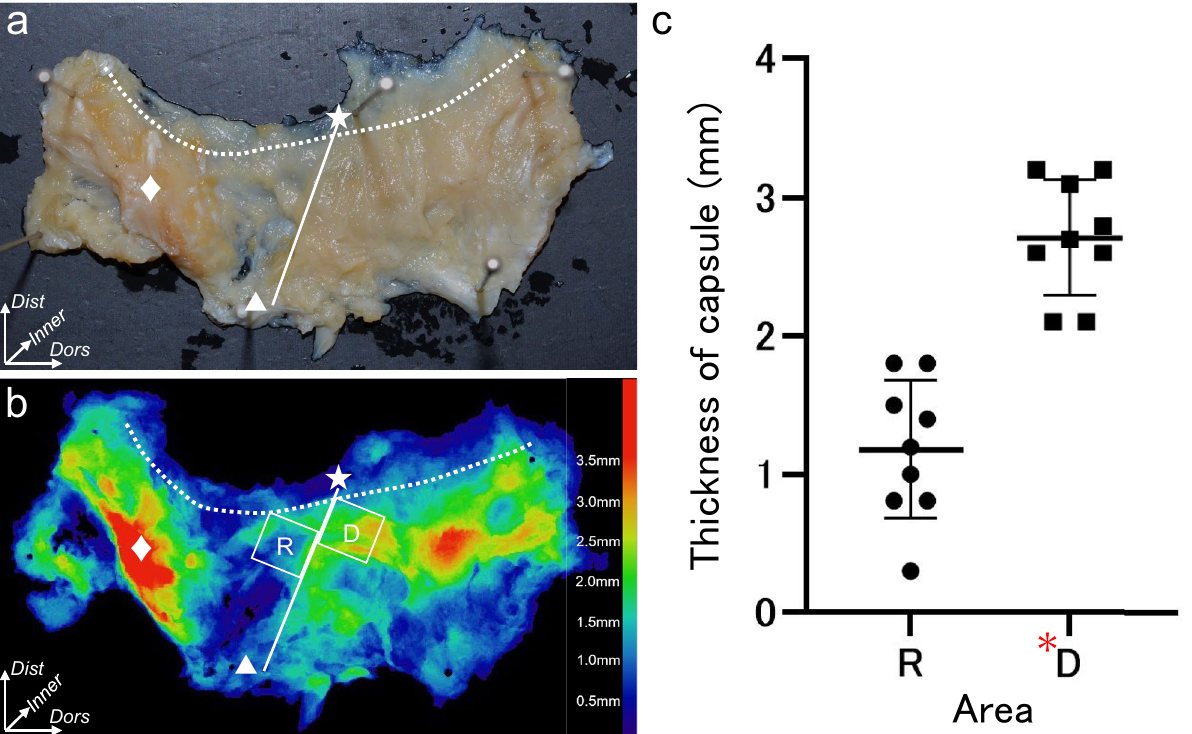
Figure 5. Distribution of the local thickness of the trapeziometacarpal joint capsule. ( a ) appearance of the trapeziometacarpal (TMC) joint capsule from the palmar aspect to the dorsal aspect (right thumb). The white star indicates attachment on the dorsoradial edge of the first metacarpal bones. The triangle indicates attachment of the APL supernumerary tendon. The rhomboid indicates the part corresponding with the radial roof of the flexor carpi radialis tendon groove (Dagger in Fig. 1c,d). The dotted line demonstrates the proximal edge of the attachment on the first metacarpal bone. The solid line indicates the borderline between the radial and dorsal aspects of the joint. ( b ) distribution of the local thickness of the joint capsule. The symbols are the same as in ( a ). Boxed regions R and D correspond to the radial and dorsal aspects of the TMC joint, respectively. The approximate thicknesses (mm) are shown by different colors in the color bar. c: scatter diagram showing the thicknesses of the R and D regions as shown in ( b ). The thicknesses are presented as means and standard deviations. Region D (red asterisk) is thicker than region R (paired t-test, P = 0.0000176). Dist , distal; Dors ,